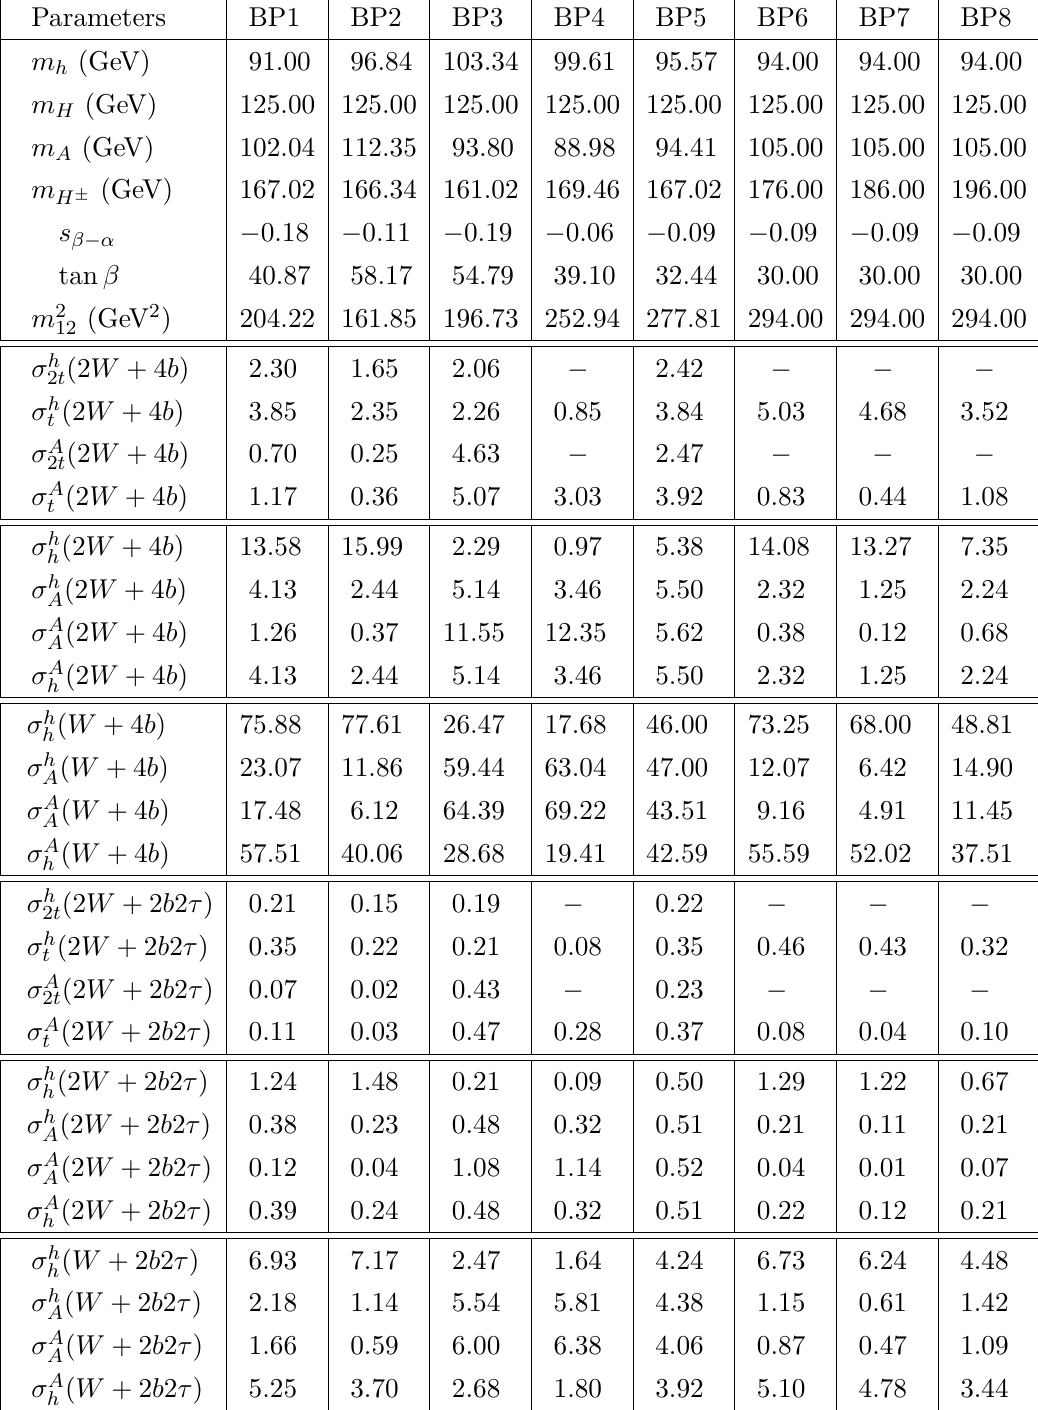
Table 5 . Mass spectra and mixing angles in the Type-I scenario, alongside cross sections (in fb) from different production channels, are